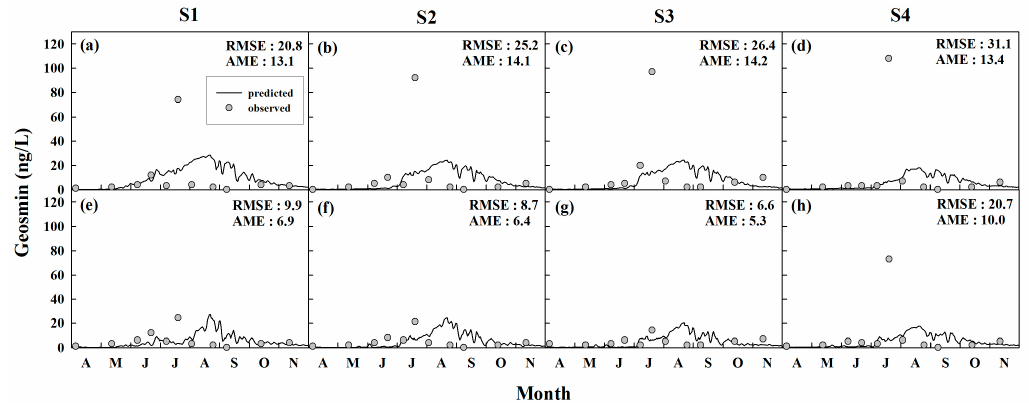
Figure 7. Predicted and observed geosmin concentrations at S1–S4; ( a )–( d ) upper; ( e )–( h ) middle.